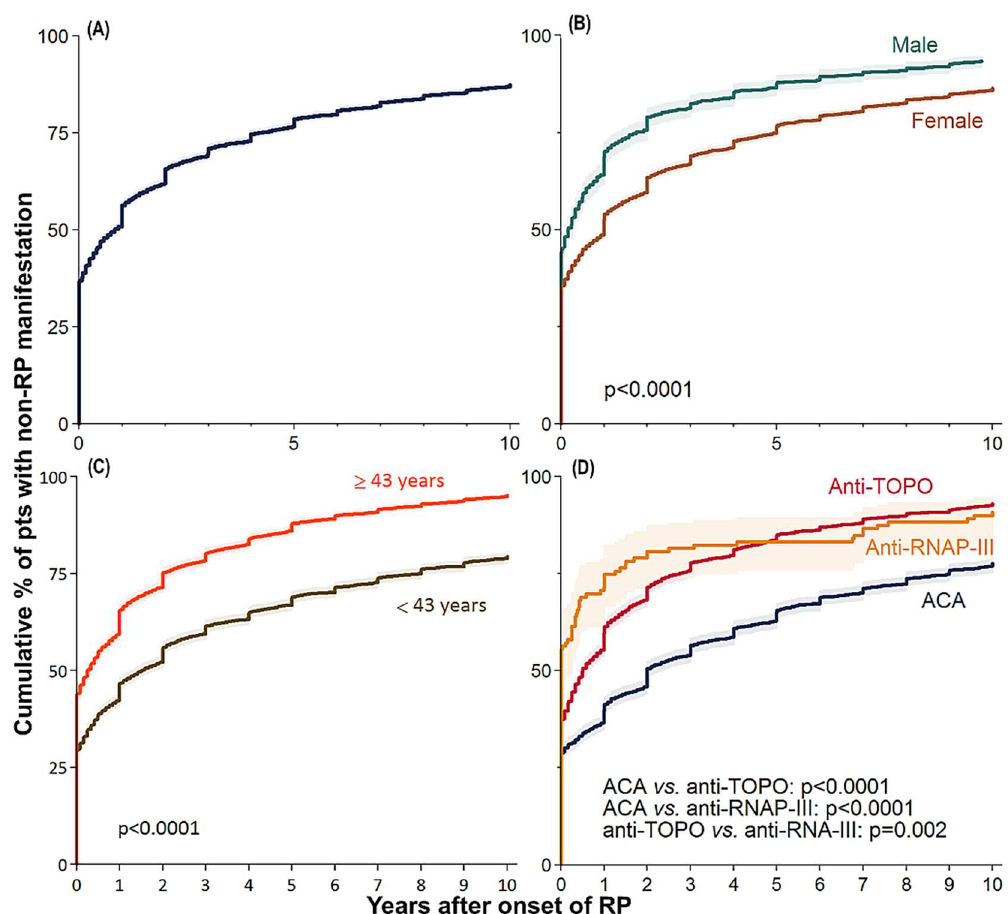
Fig 2. Kaplan-Meier curves with 95% CI of the manifestation of any first non-RP feature after RP onset in all SSc patients in the entire EUSTAR cohort (A) and stratified by sex (B), the median age at RP onset (C) and the autoantibody status (D). CI, confidenceinterval; RP, Raynaud’s phenomenon; Pts, patients; ACA, anti-centromere autoantibodies; anti-TOPO, anti-topoisomerase-I autoantibodies; anti-RNAP-III, anti-RNA-polymerase-III autoantibodies; hash marks represent censored